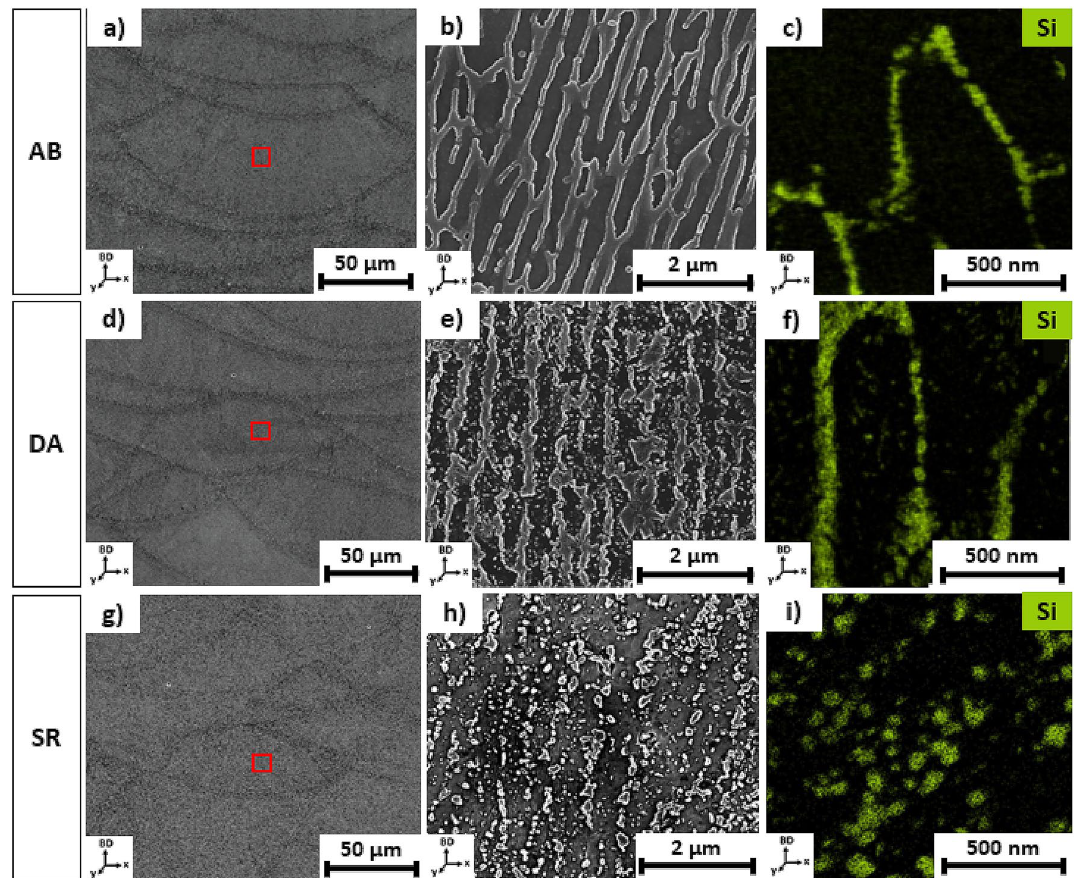
Figure 5. SEM images and Si STEM-EDX maps taken from the bulk material with vertical cross-sections along the building direction (BD) for the respective conditions: ( a )–( c ) as-built (AB); ( d )–( f ) direct-aged (DA); ( g )–( i ) stress-relieved (SR). The low-magnification images ( a ), ( d ), and ( g ) display the bulk mesostructure across several layers. The high-magnification images ( b ), ( e ), ( h ); and the Si STEM-EDX maps ( c ), ( f ), ( i ) are taken from the meltpool centre, indicated by the red-squared area.